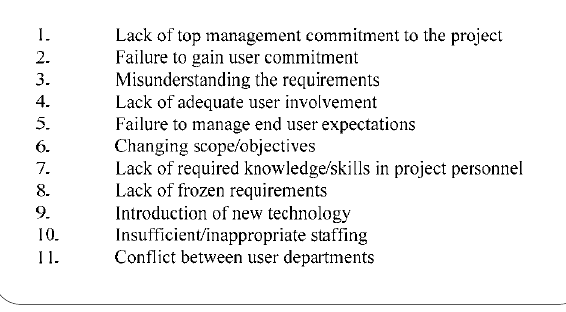
Figure 2: Keil et al.'s 'top eleven' list of software risk items. (Keil et al ., 1998)